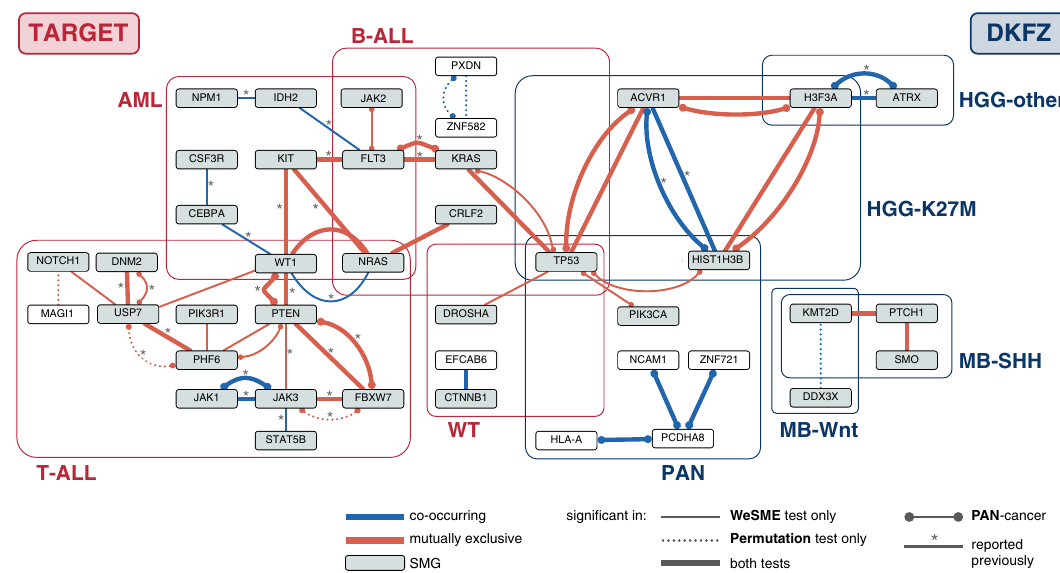
Fig. 3 Candidate gene pairs resulting from the genetic interaction detection pipeline. Graph depicting candidate genetic interactions found in either TARGET (red boxes) or DKFZ (blue boxes). Mutually exclusive pairs are indicated in red, co-occurring pairs in blue. SMG signi fi cantly mutated genes. “ reported previously ” refers to gene pairs that were detected as signi fi cantly co-occurring or mutually exclusive in the studies accompanying the TARGET 7 and DKFZ 6 data sets. Source data underlying Fig. 3 can be found in Supplementary Data